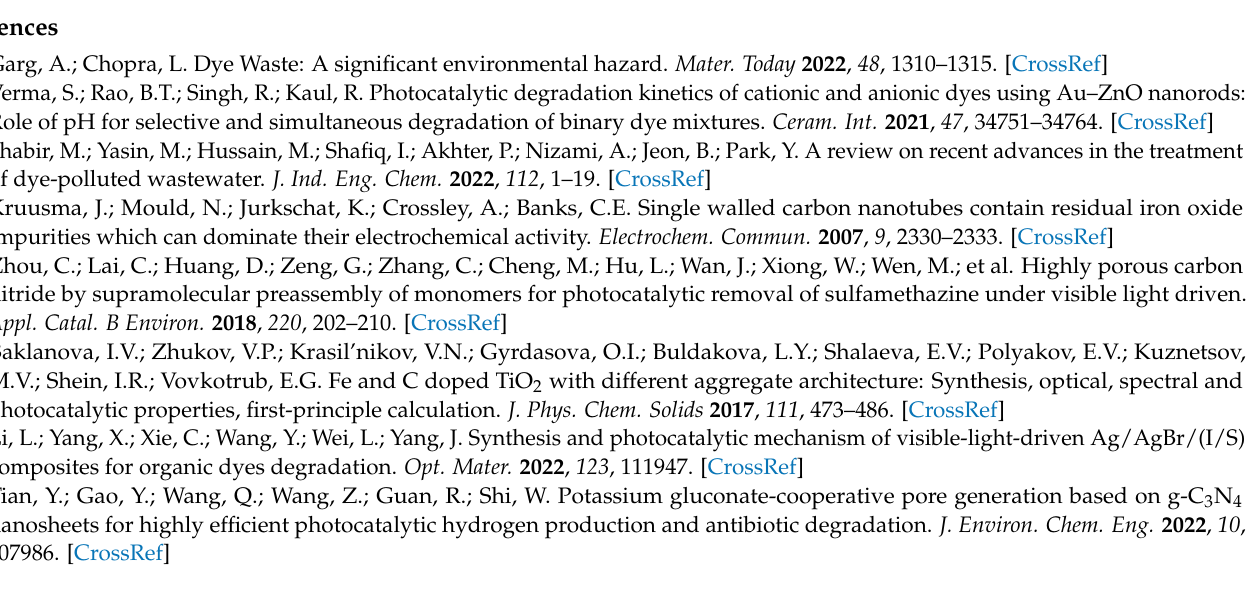
Figure S10: potential of CaWO 4 solution at different pH values; Figure S11: UV–vis spectra in the course of photocatalytic